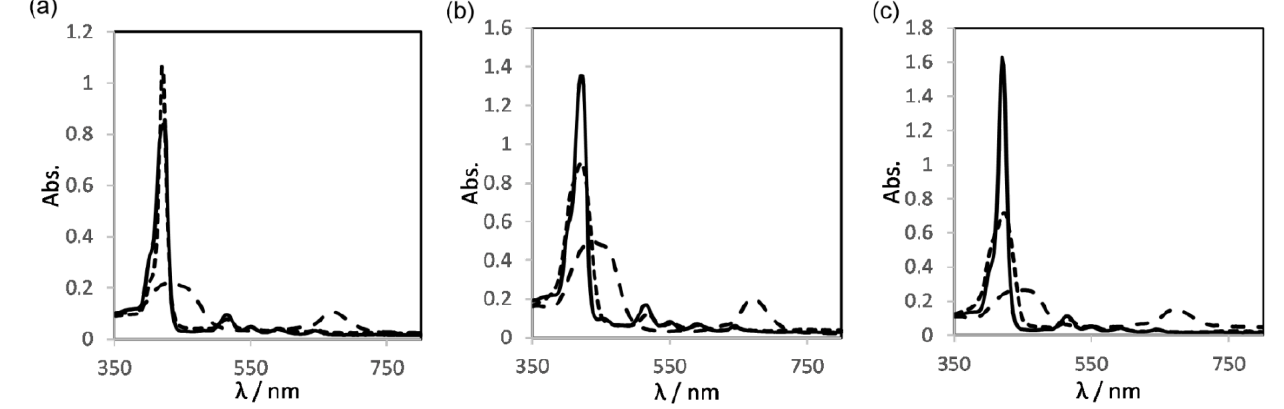
Figure 1. Absorption spectra normalized of porphyrins C5SHU, C6SHU, and C7SHU spectra ( a ), ( b ), and ( c ), respectively, in different solvents made up from the 6 mM NaOH stock solutions. Solid black lines represent the spectra of the porphyrin in DMSO, black dotted line represent the spectra of the porphyrin in water and the black dashed line represents the spectra of the porphyrin in 1 M HCL.